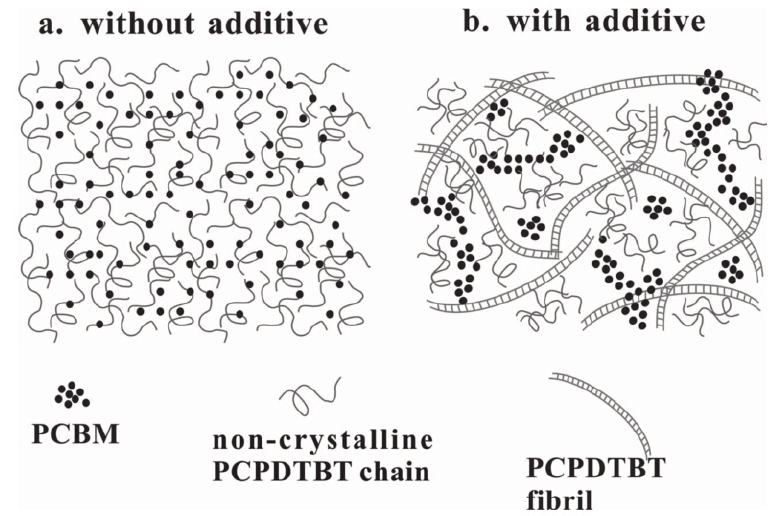
Figure 20. Morphology for PCPDTBT/PCBM thin films processed without additives ( a ) or with additives ( b ). Cited from [158]. Copyright 2012,